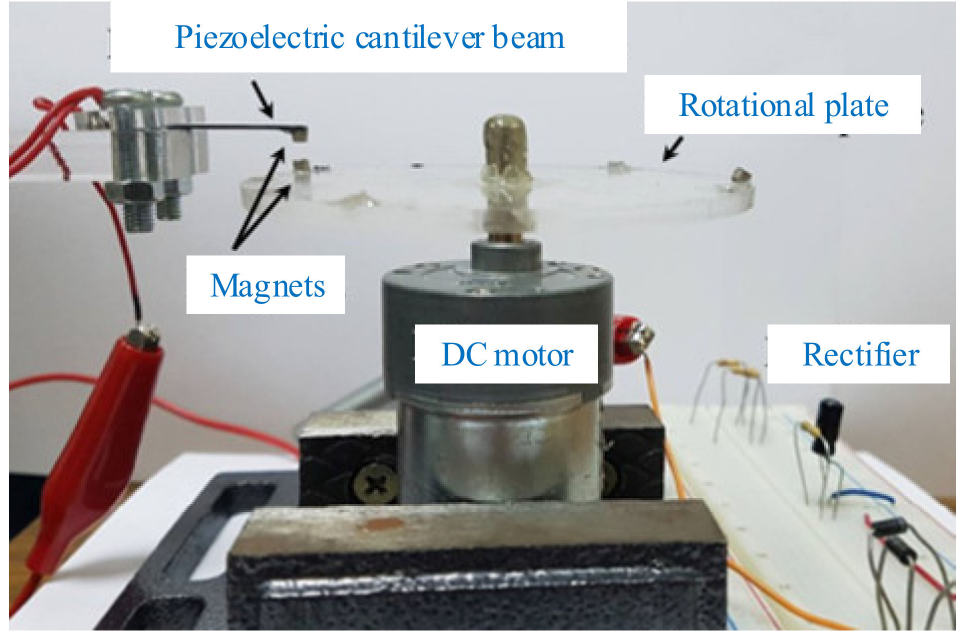
Figure 13. The rotational mechanism (reproduced with permission from [187]; published by Else- vier B.V.,